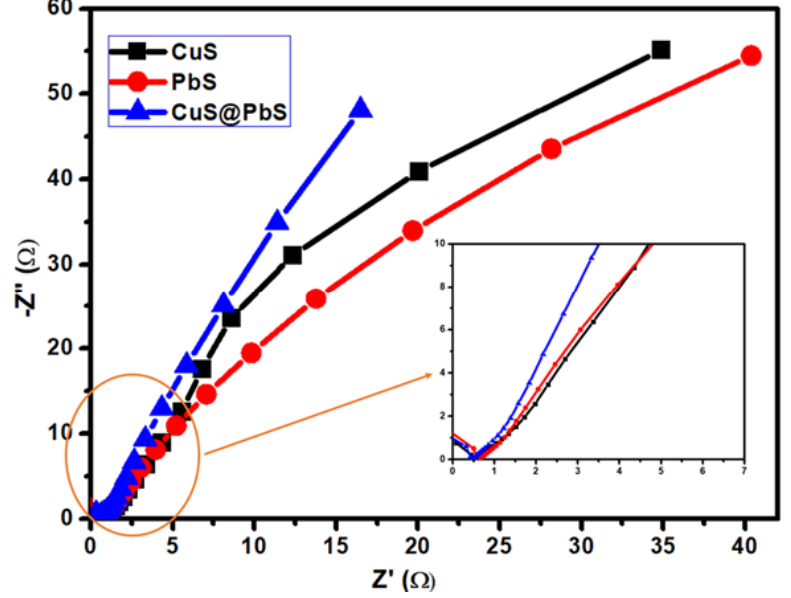
Figure 7. Impedance Nyquist plots of the CuS, PbS and CuS@PbS electrodes.